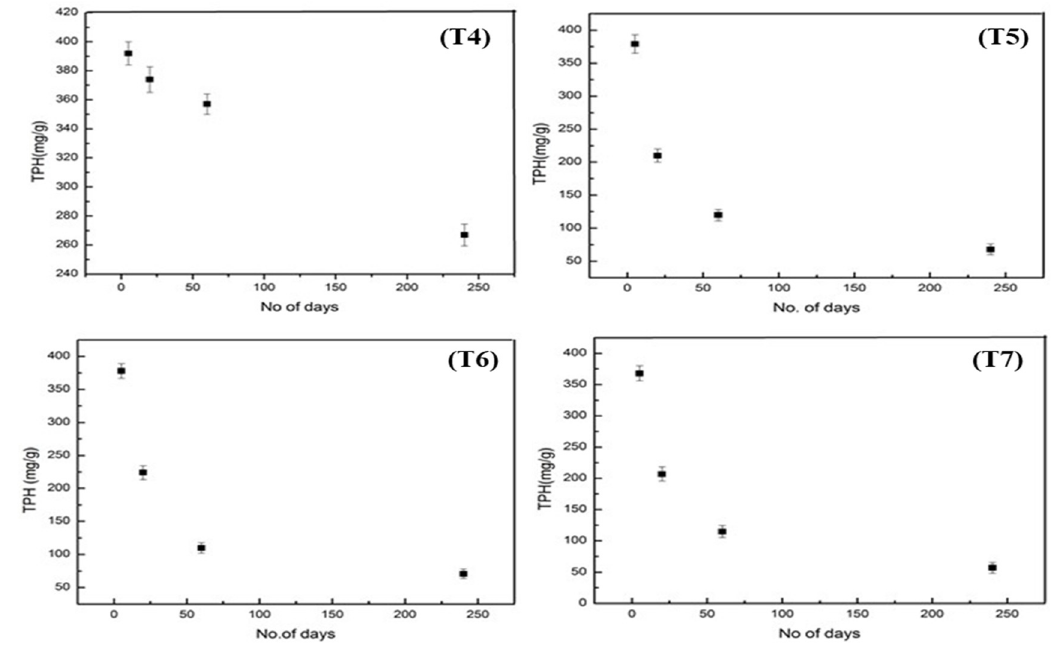
Figure 3. The difference in the degradation of TPH with respect to time (No. of days) in treatments (T1–T7) and (T0). The values are the mean and standard error ± of three replicates.